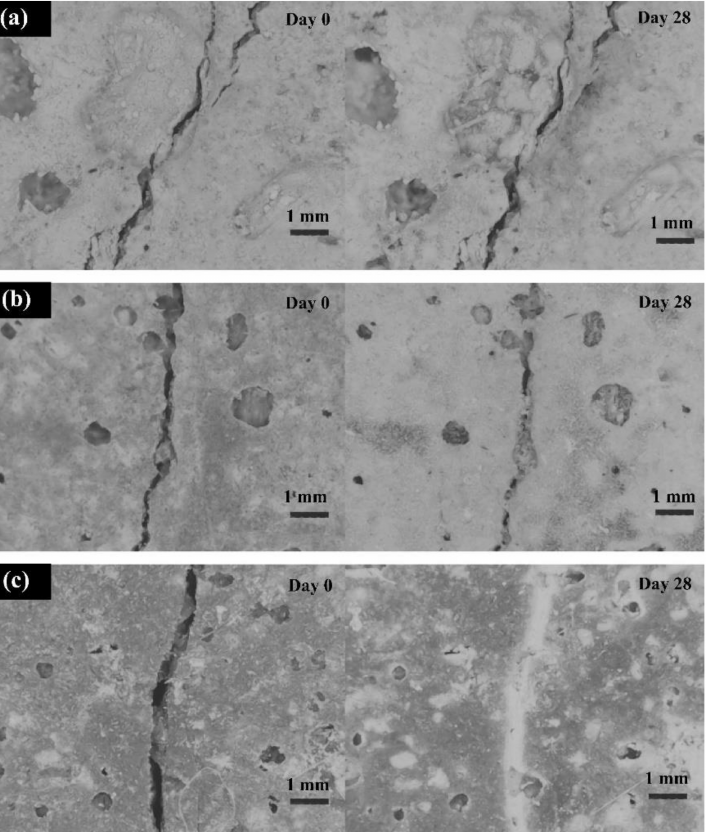
Figure 3. Evolution of crack healing via microbial process: ( a ) reference; ( b ) abiotic control; ( c ) micro- bial (Adapted with permission from Elsevier